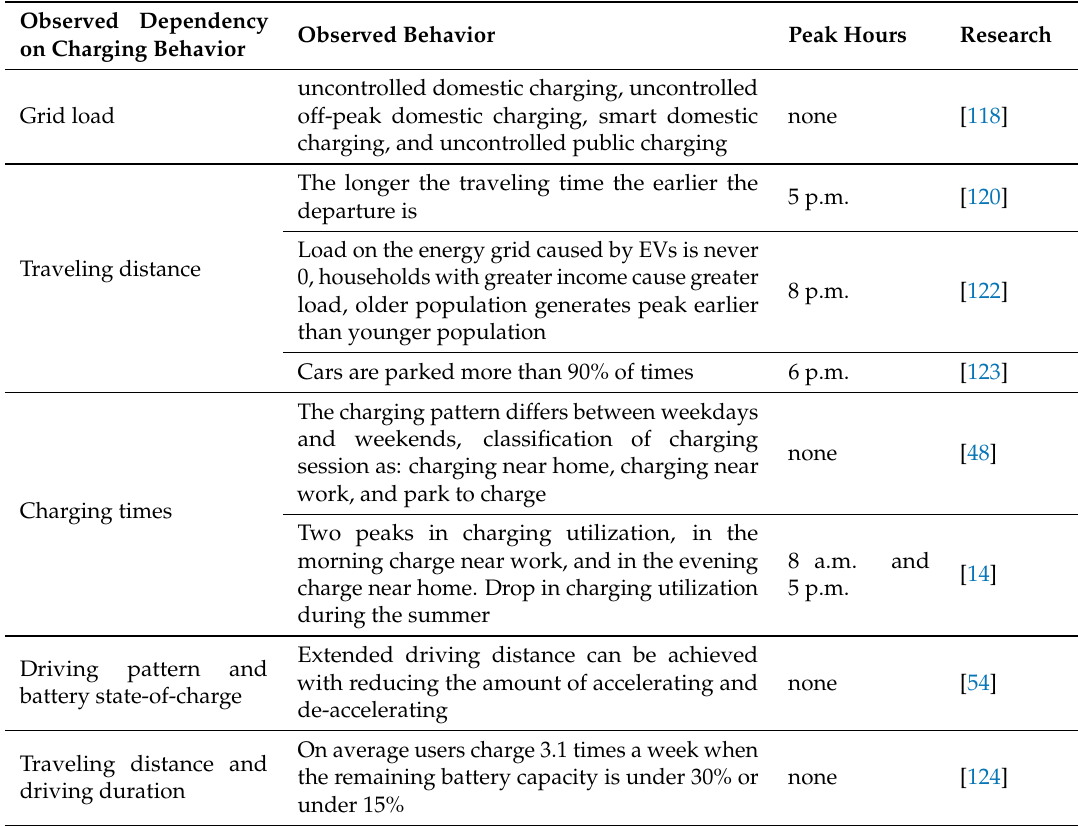
Table 5. EV owners’ charging behavior and